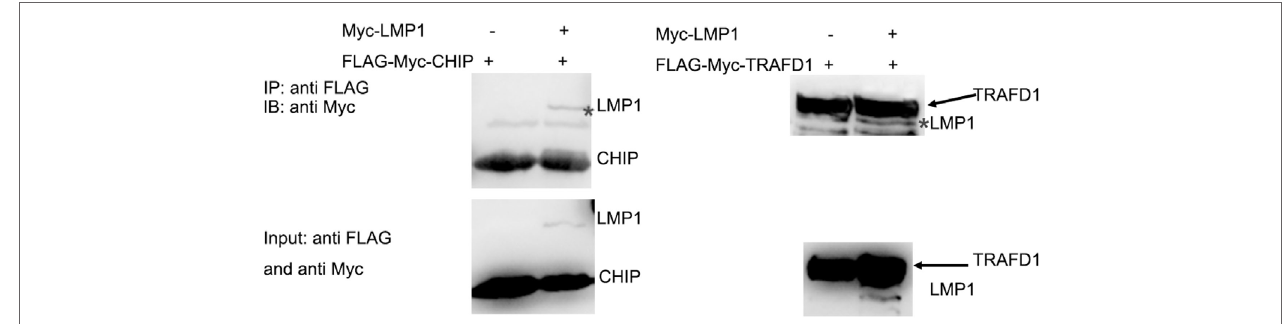
FigUre 3 | LMP1 interacts with E3 ligases CHIP and TRAFD1. The 293T cells were transfected with plasmids E3 ligases FLAG-Myc-CHIP (MW: 28 kD) or FLAG-Myc-TRAFD1(MW: 65 kD) with Myc-LMP1 (MW: 55kD). After transfection of 24 h, Co-IP was performed with cell lysates with antibodies to FLAG tags. Immunoblot analysis of Myc-LMP1-immunoprecipitated by FLAG-tagged E3 with antibodies to c-Myc. Upper panel shows the IP results performed with anti-FLAG monoclonal antibody, and immunoblot analysis with anti Myc. The lower panel shows the input, immunoblot with anti-FLAG and anti-Myc monoclonal antibodies. * represents immunoprecipitated Myc-LMP1.